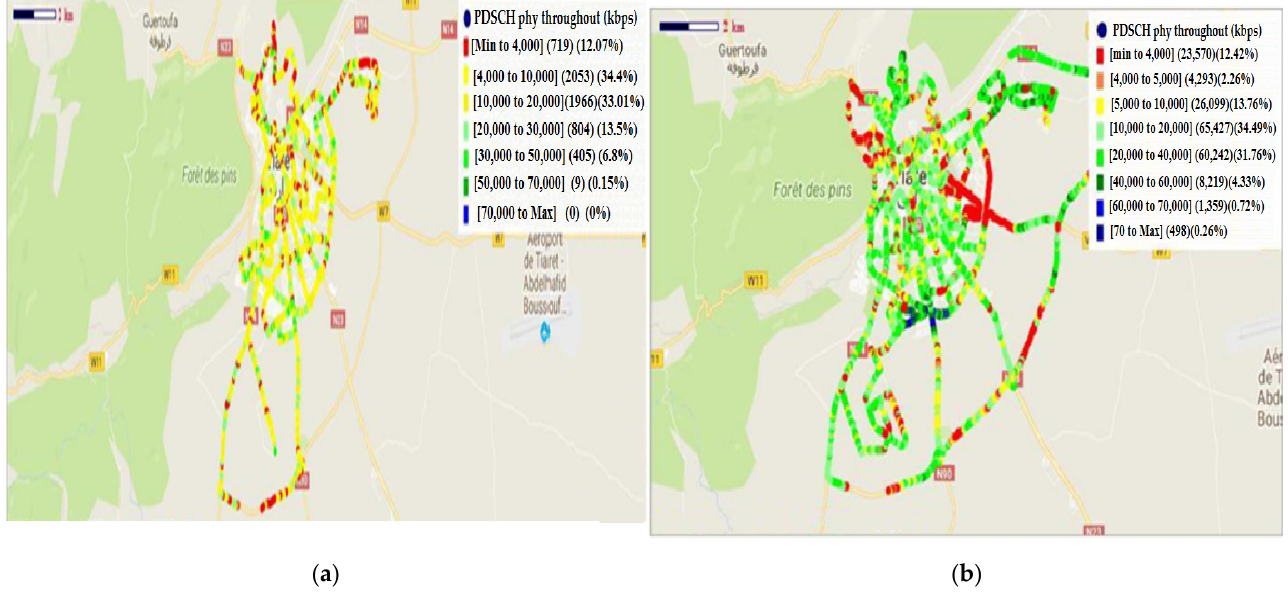
out before and after treatment are given in Figure 13.